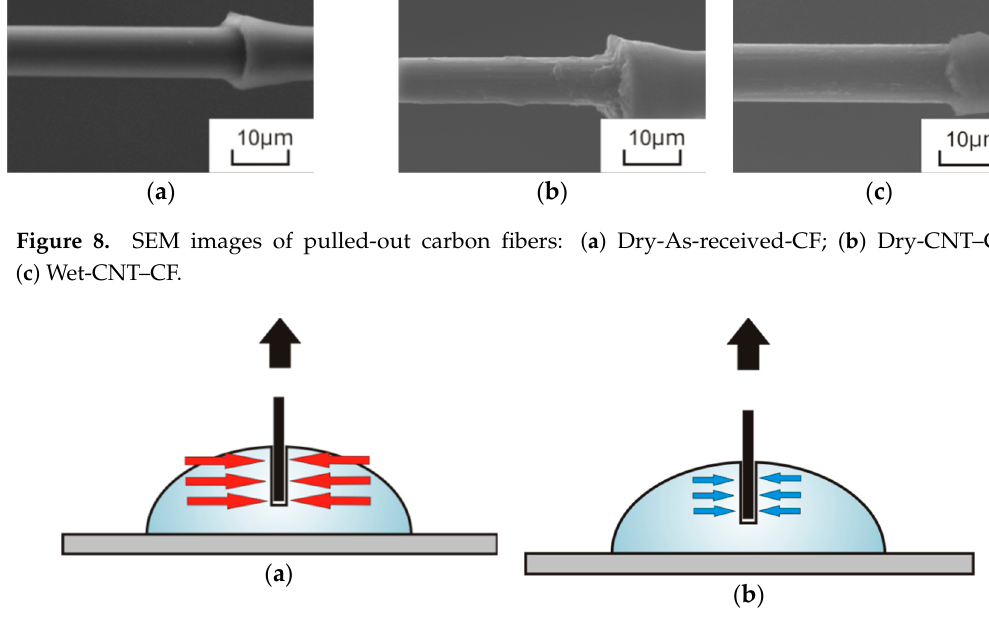
Figure 9. Schematic drawings of residual stress at the fiber–matrix interfaces: ( a ) Residual stress by thermal shrinkage of the resin; ( b ) At high temperatures [24].